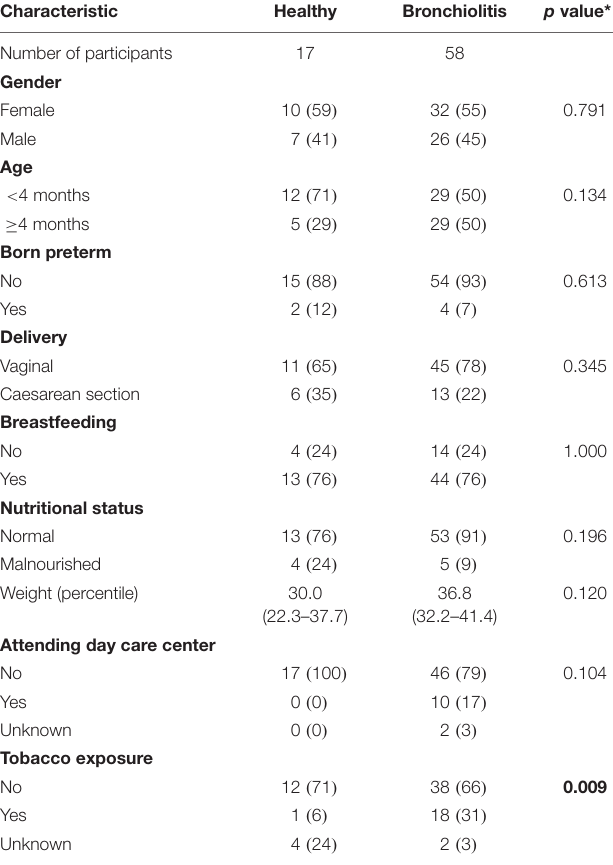
TABLE 1 | Participant characteristics.